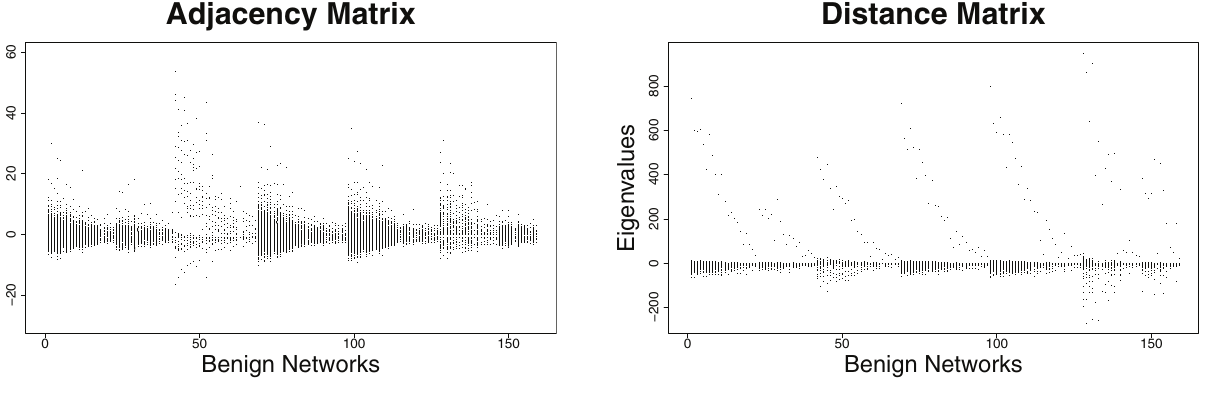
Figure 1. Distributions of the Eigenvalues of the adjacency matrix for the benign networks.